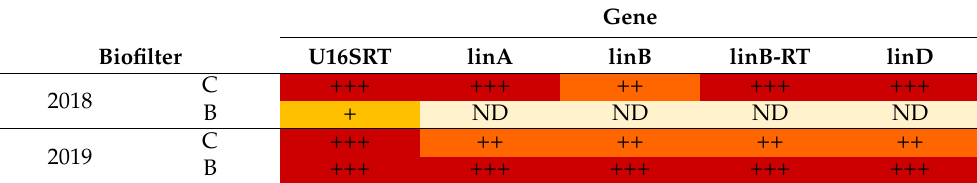
Table 1. Relative abundance of genes indicating total bacterial biomass ( 16S rDNA ), dehydrochlori- nase ( linA ), haloalkane dehalogenase ( linB, linB-RT ), and reductive dechlorinase ( linD ) in the control biofilter (C, average of duplicate samples) and biochar sediments (B, average of duplicate samples). The color scale indicates the relative quantity of a given marker: red (+++) highest, orange (++) high, and yellow (+) intermediate quantity, ND = not detected or below the LOQ. Gene Biofilter U16SRT linA linB linB-RT linD 2018